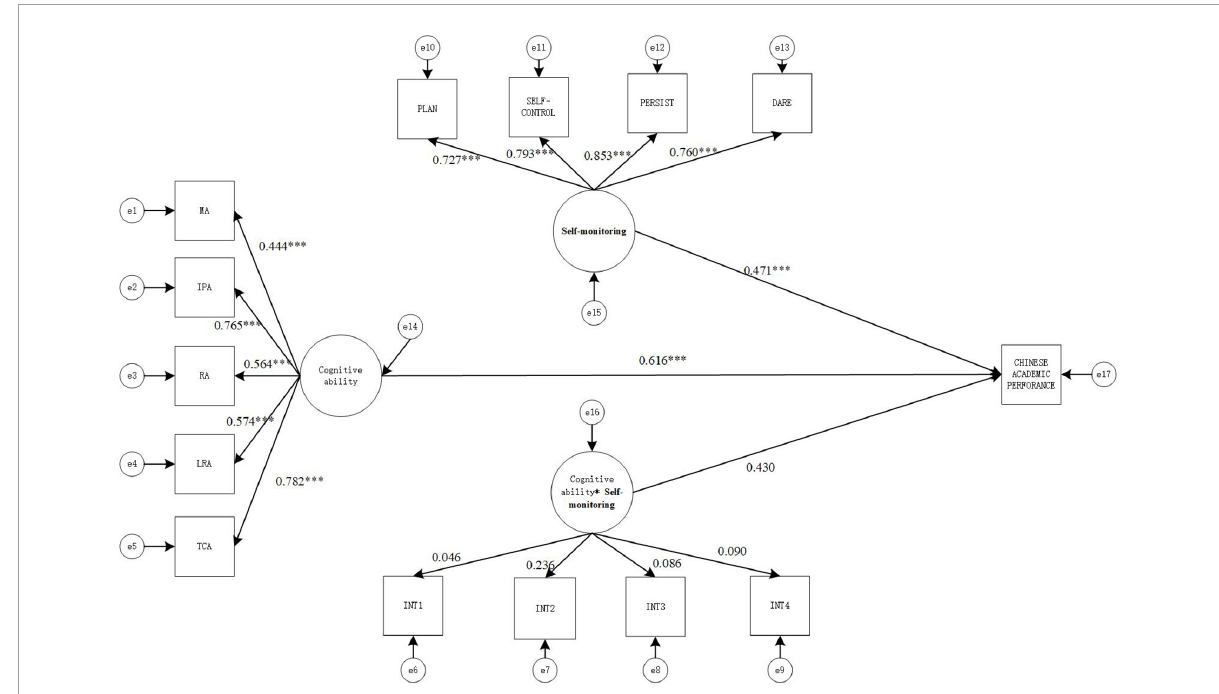
FIGURE3 Structural equation moderating effect relationship model diagram (model 2). MA, memory ability; IPA, information processing ability; RA, representation ability; LRA, logical reasoning ability; TCA, thinking conversion ability.* p < 0.05, ** p < 0.01, and *** p < 0.001.